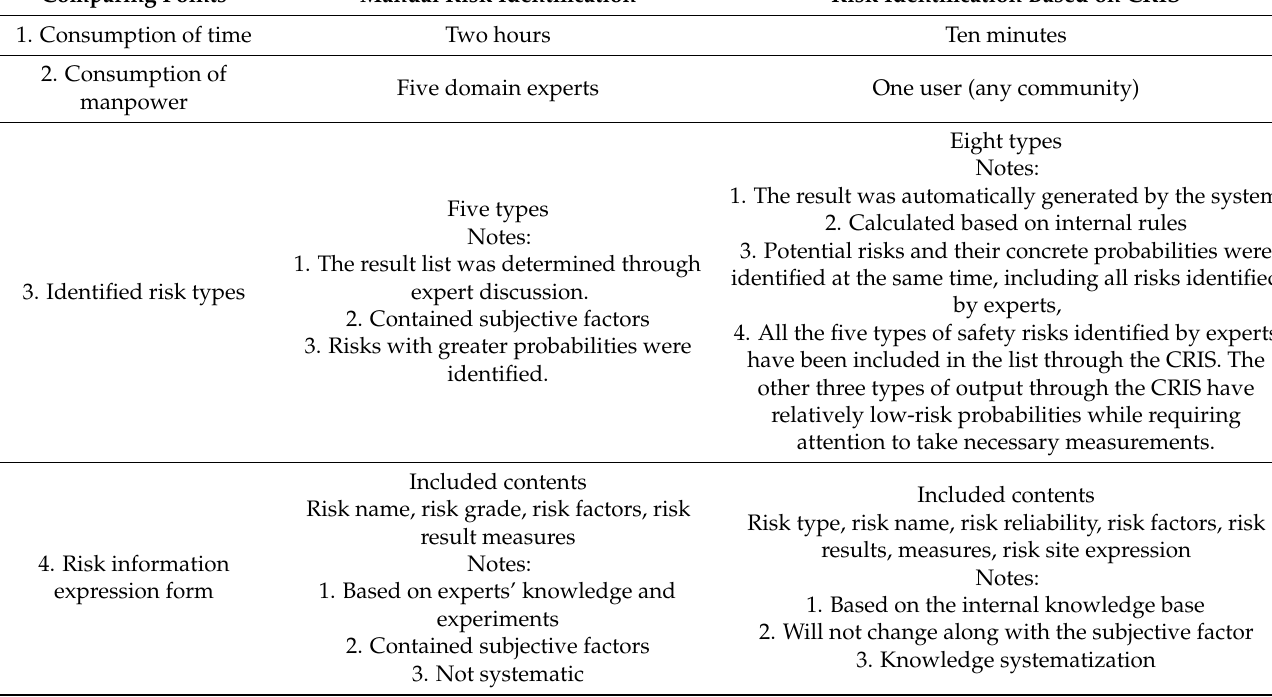
Table 6. Comparison of the safety risk identification process between the CRIS prototype and the seminar Comparing